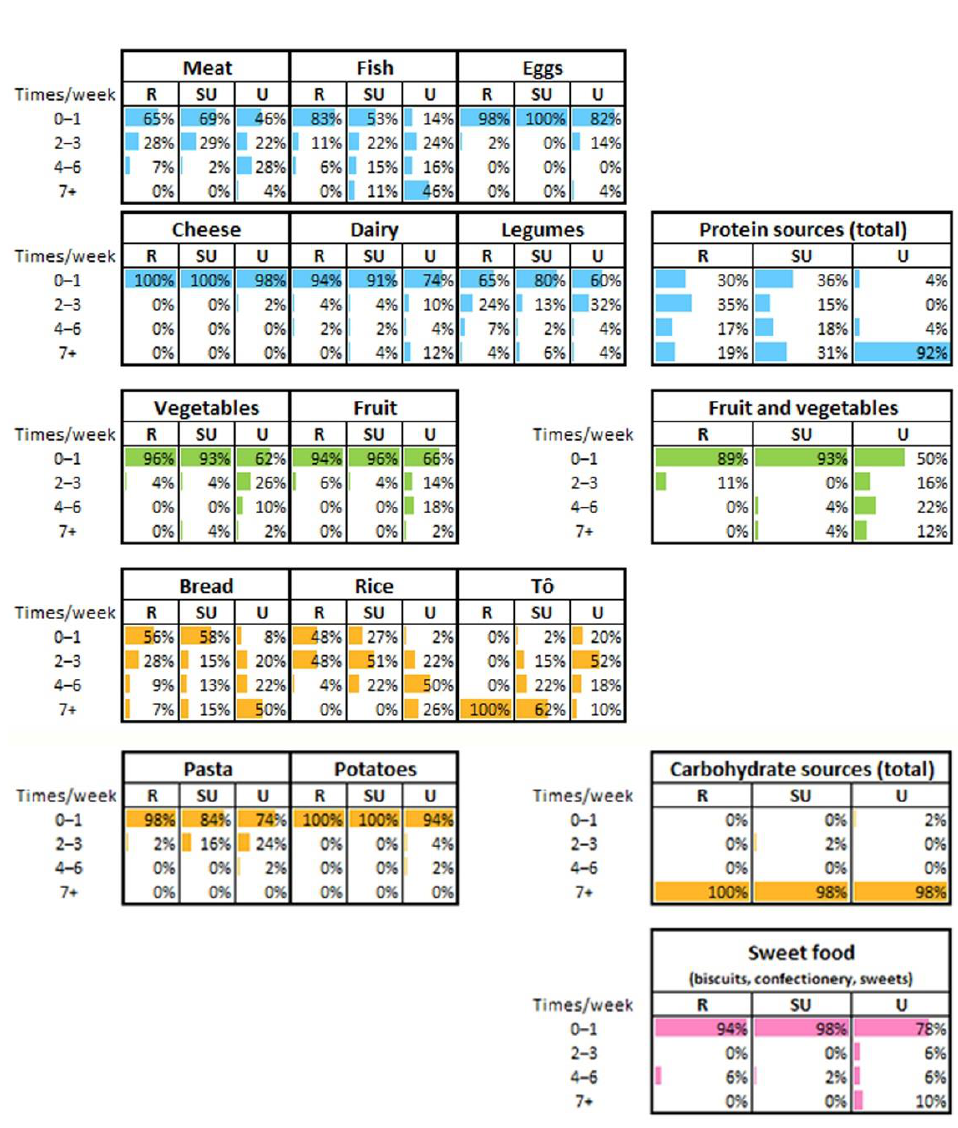
Figure 4. Weekly frequency of food consumption. The frequency of consumption of the categorized food items was referred to the seven days prior to the interview. Data are referred to all the enrolled individuals, without distinction of age. R = rural; SU = semi-urbanized; U = urban cohorts. Percent- ages may not add up to exactly 100% due to rounding. Right panel: Table of the total protein sources showing the proportion of individuals from the three cohorts that consume food rich in proteins (such as meat, fish, egg, cheese, dairy and legumes). Similarly, table of fruit and vegetables showing the proportion of individuals consuming weekly both fruits and vegetables; table of total carbohydrate sources showing the proportion of individuals consuming weekly foods rich in carbohydrates (such as bread, rice, to, pasta and potatoes); table of sweet food showing the proportion of individuals consuming weekly foods rich in simple sugars.